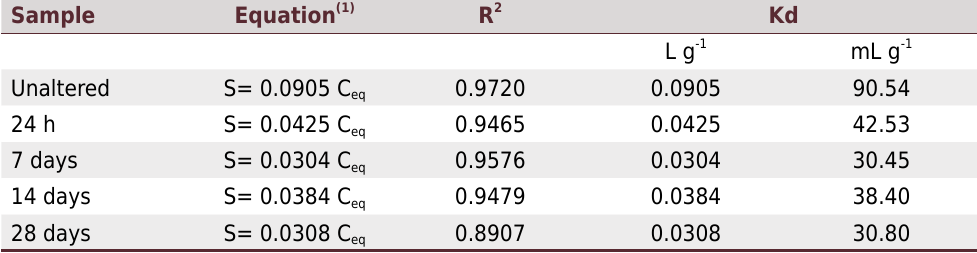
Table 2. Linear isotherm adjustments for Kd (Cs) determination before and after each interaction period (24 h and 7, 14, and 28 days) with the alkaline solution. Experimental conditions for